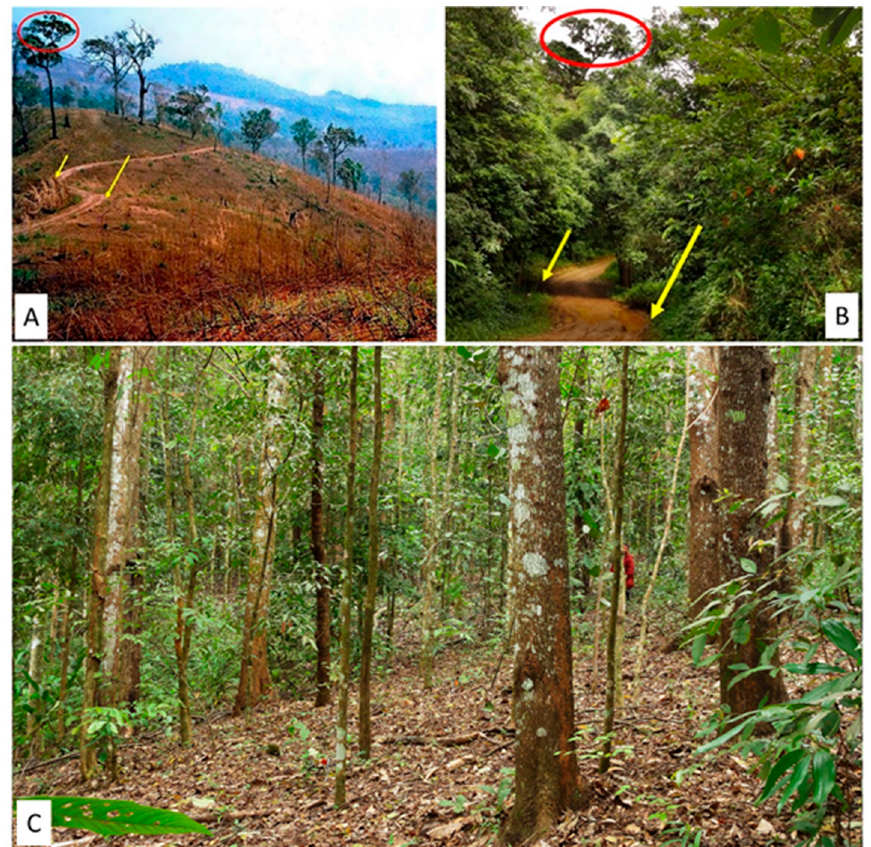
Figure 4. Forest restoration using the framework-species method has transformed the landscape of the upper Mae Sa Valley. ( A ) May 1998 before restoration; ( B ) same site, left of the track, restored forest, 15 years old, planted 2001; right, 9-year-old restored forest, planted 2007 (photo September 2016). ( C ) Inside nearby restored forest, 18½ years old, a dense understory develops that comprises seedlings and saplings of >70 recruit tree species.